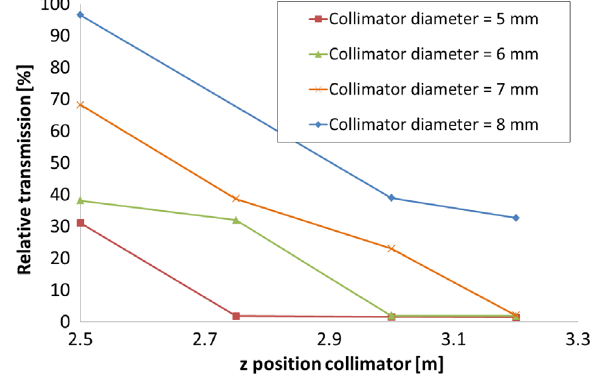
FIG. 25. Simulated transmission of the dark current at the exit of the second S-band structure at SwissFEL. The number of particles is normalized to those at the FC. The first accelerating structure is installed at 3.3 m from the